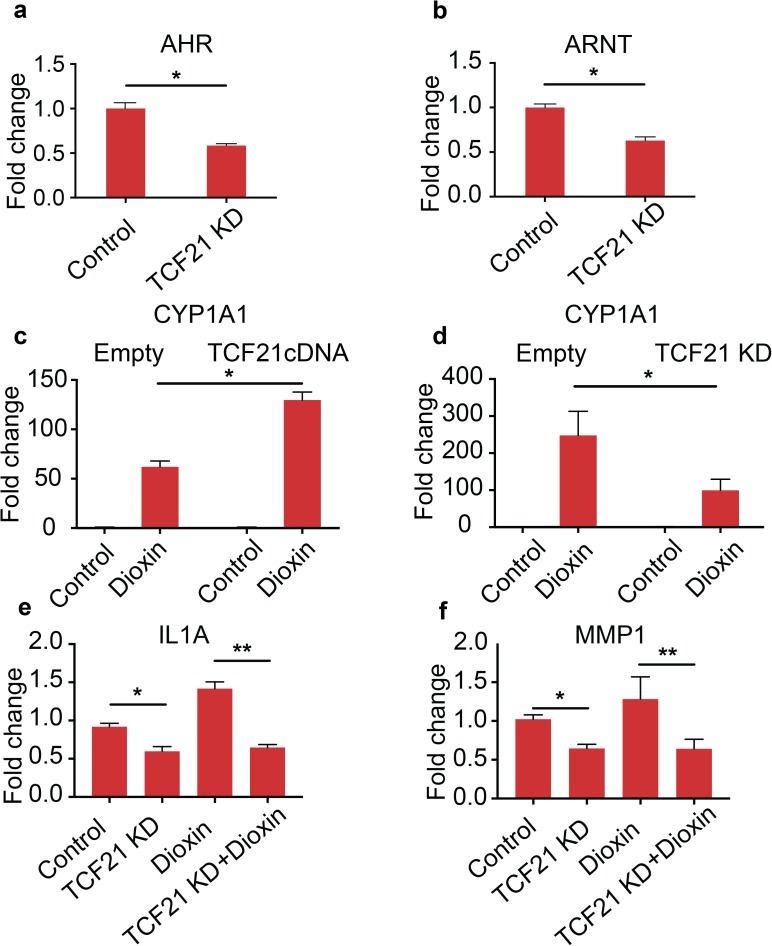
TCF21 modulates expression of AHR and its downstream genes.(a, b) Knock-down of TCF21 reduces expression of AHR and ARNT in HCASMC. (c, d) Over-expression of TCF21 further increased expression of CYP1A1 in HCASMC induced by dioxin treatment, while siRNA mediated knock-down of TCF21 attenuated expression of CYP1A1 in HCASMC that was induced by the treatment with dioxin. (e, f) TCF21 knockdown by siRNA decreased expression of both IL1A and MMP1, while dioxin alone increased expression of both genes. Also, TCF21 knockdown completely blocked the dioxin-mediated increase in expression for both genes.